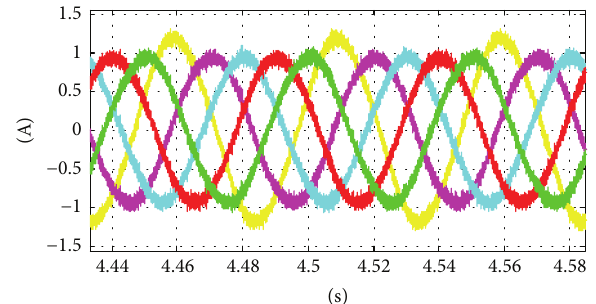
Figure 9: Phase current waveforms of the five-phase PMSM under 20% ITSC fault in phase A.